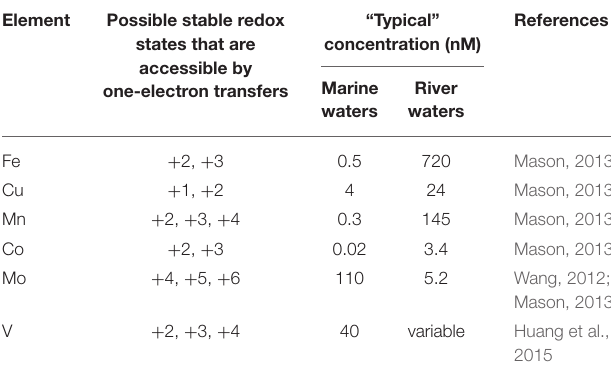
TABLE 1 | Trace metals that can potentially be interconverted between multiple redox states through one electron transfers in oxygenated natural